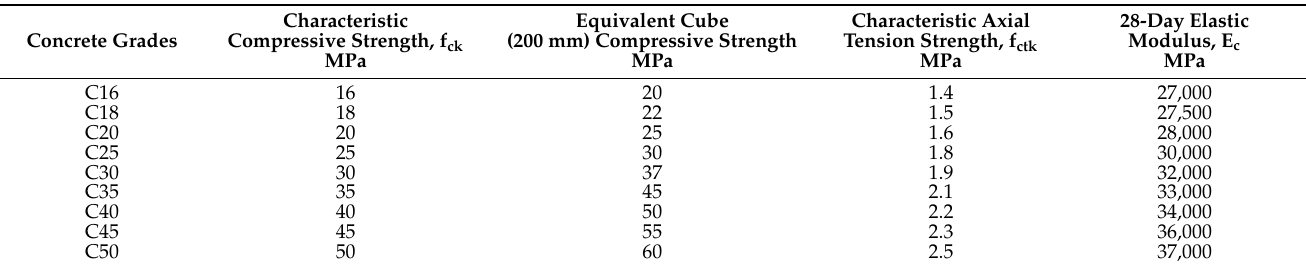
Table 1. Concrete grades and strength [9].